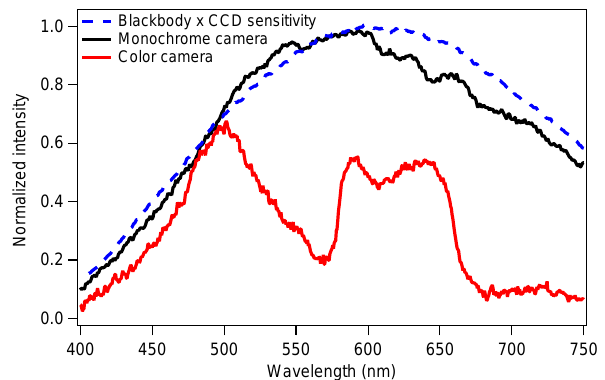
Figure 5. Comparison of white-light scattering from ground sodium chloride (NaCl) particle detected by color (solid red) and monochrome (solid black) cameras. Reference spectrum (dashed blue) shows calculated blackbody radiator at 3000K multiplied by CCD sensitivity curve as an estimate of light intensity as a func- tion of wavelength expected at detector. Red curve was normalized to 1.0 and then scaled down by an arbitrary value to show reduced emission intensity above 500nm.